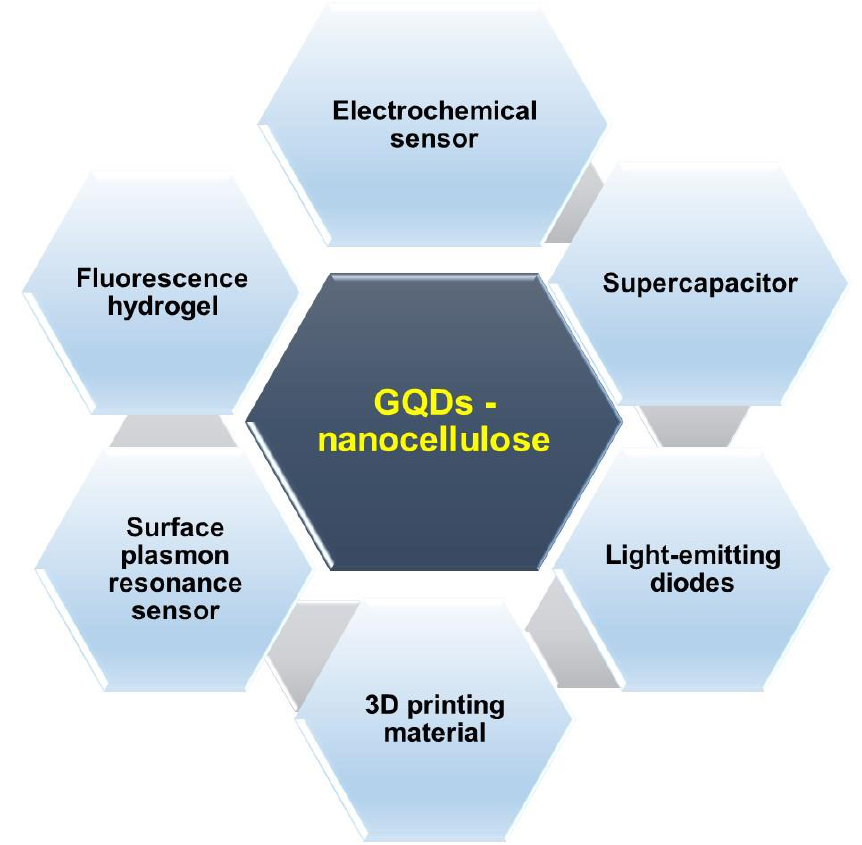
Figure 5. The applications of GQDs – nanocellulose composites.